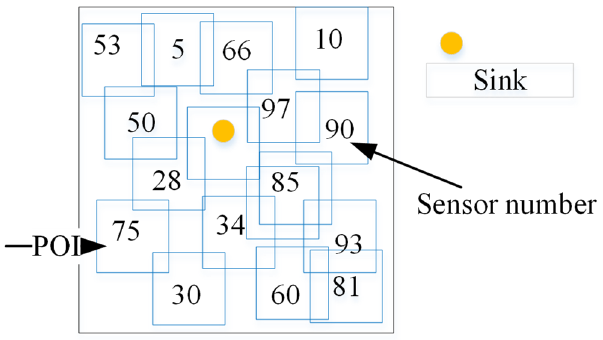
Figure 5. Coverage scenario in a WSN using the suggested